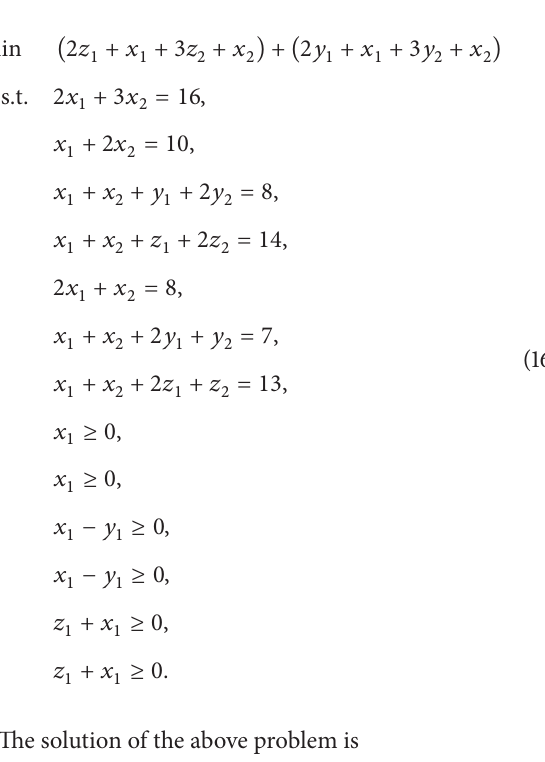
Table 2: The solution of Example 11 by Ezzati et al.